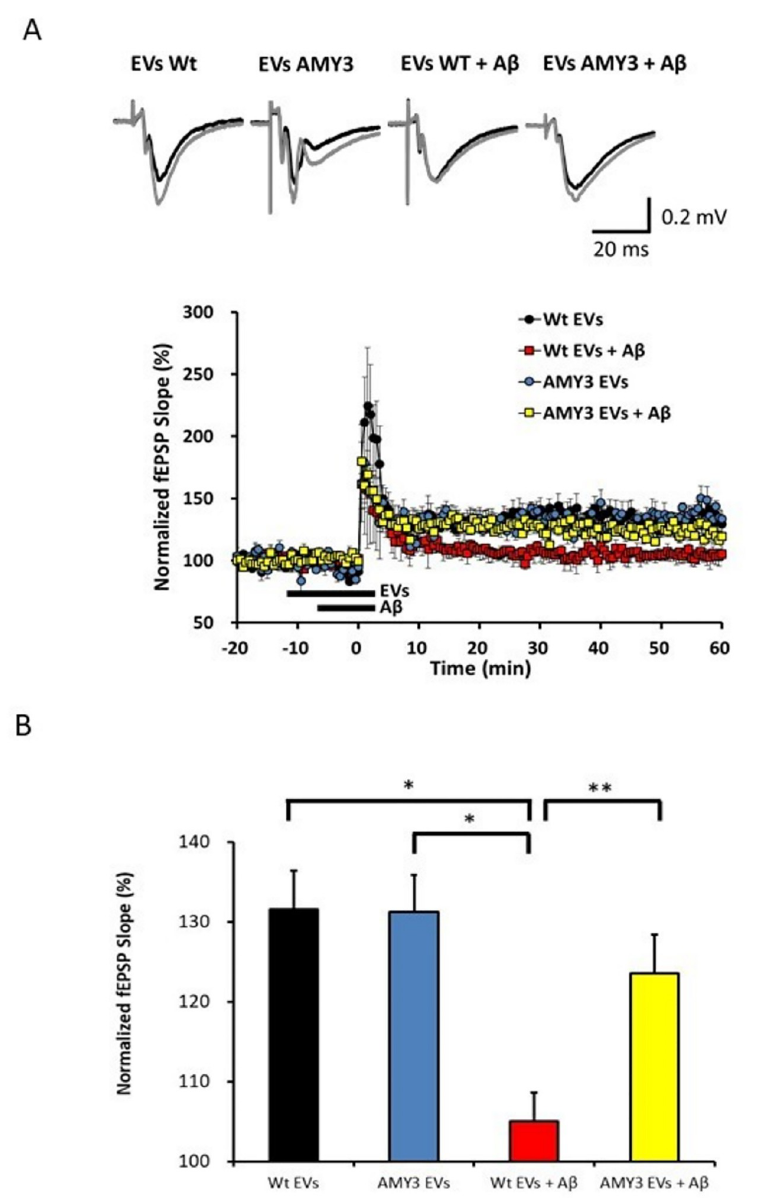
Fig 4. AMY3 derived EVs attenuate A β -induced depression of hippocampal LTP. A , LTP in mouse hippocampal brain slice was induced by × 3 TBS protocols and EVs from either AMY3 or Wt cells were perfused 5 min prior to applications of soluble oligomeric 50 nM A β 1–42. Each point indicates the fEPSP slope normalized to the average baseline response over 10 min prior to EV applications; the bars indicate onset and duration of application (Wt EVs (black), Wt EVs + A β 1–42 (red), AMY3 EVs (blue), and AMY3 EVs + A β 1–42 (yellow), n = 6 for each group, one brain slice per mouse). All data are presented as mean ± SEM. Traces shown above the LTP data are the average of fEPSPs recorded during baseline (black) and 40–60 min after × 3 TBS (grey). Calibration: 0.2 mV, 20 ms. B , Summary bar graphs show significant reductions in LTP after application of Wt EVs with 50 nM A β 1–42 , but not AMY3 EVs with 50 nM A β 1–42 � p < 0.05, �� p < 0.01, ANOVA followed Tukey’s post hoc test).